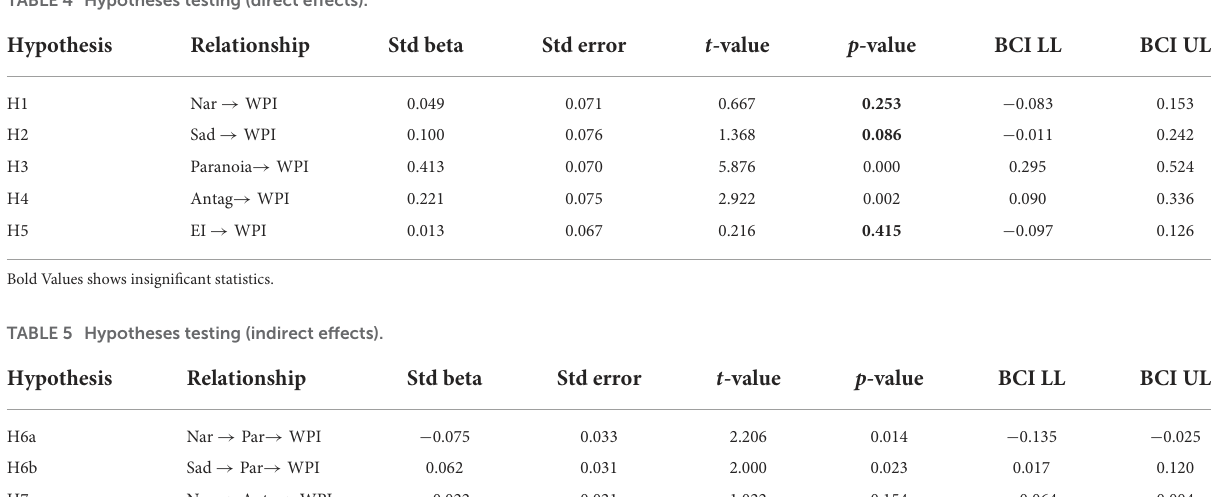
TABLE 4 Hypotheses testing (direct effects).